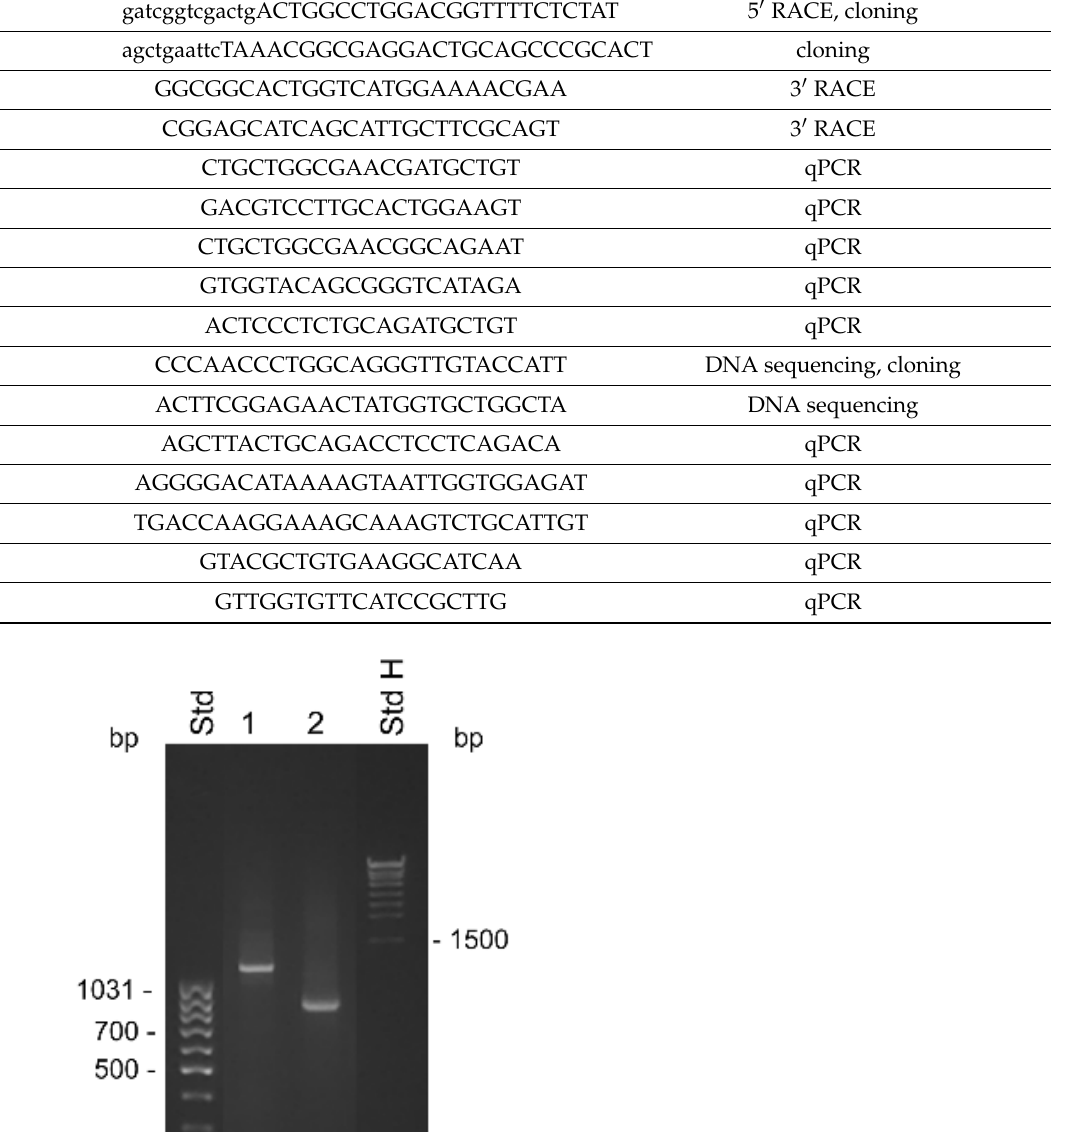
Table 1. Primers used for PCR, cloning, and DNA sequencing. Bases written in lower case are non- sequence-specific nucleotides included for the cloning procedure.